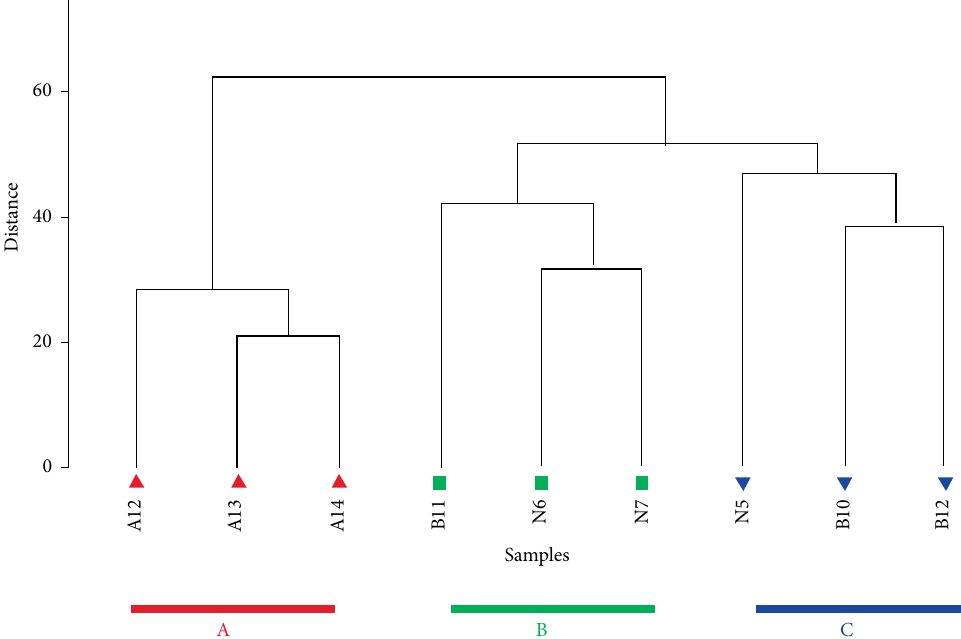
Figure 4: Dendrogram of each station centroid based on the species abundance data among sampling campaigns. Three groups of stations (arbitrarily named A, B and C) were